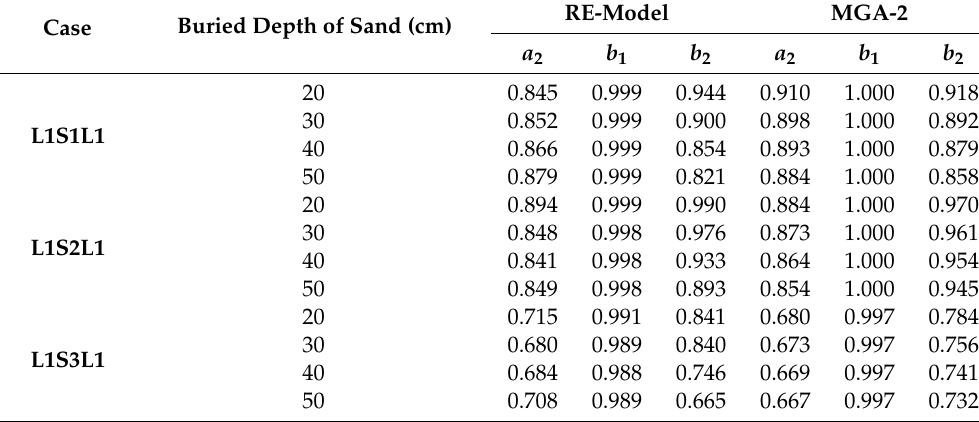
Table 5. Comparison of the saturation coe ffi cients simulated by the RE-Model and calculated by the modified Green Ampt model (MGA-2) with di ff erent buried depths of sand for cases L1S1L1, L1S2L1, and L1S3L1. Case Buried Depth of Sand